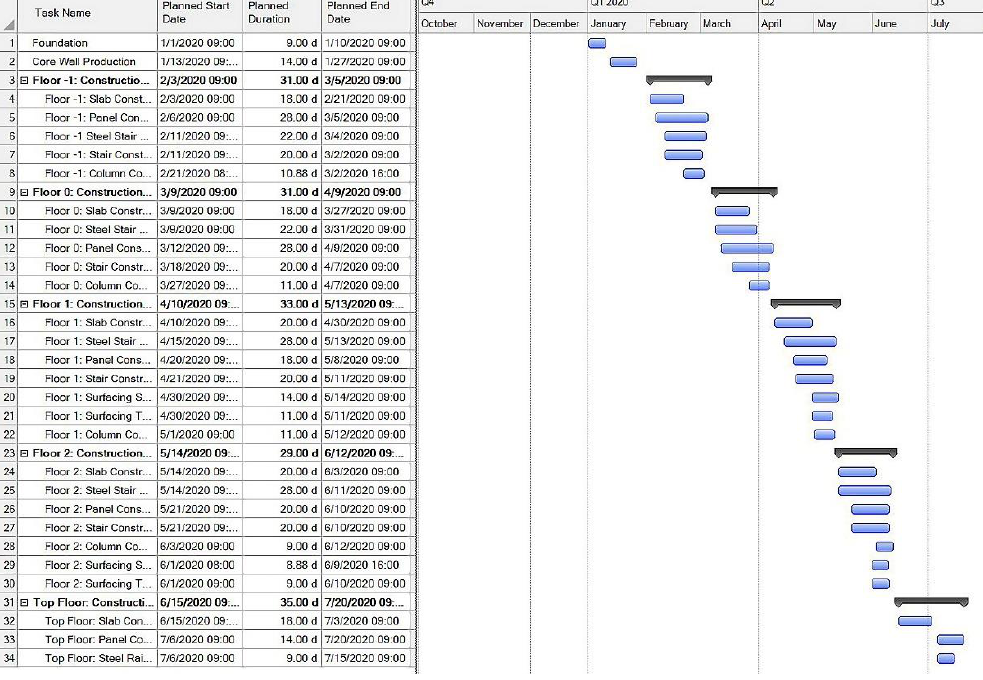
Figure 5. The Gantt chart exported by Tekla Structures and used as a benchmark for analyses involving construction project management software (CPM) software packages.